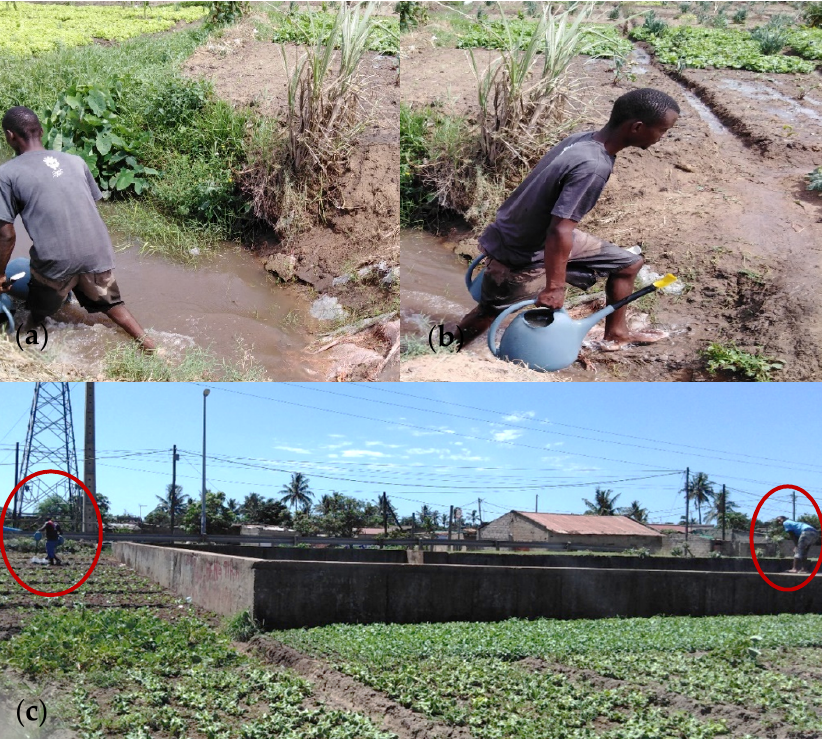
Figure 3. Farmers collecting water: ( a ) a man collecting water from artisanal well; ( b ) carrying it for irrigation in Infulene area; ( c ) manual crops irrigation (men at left) and water collection for irrigation, in a section of drainage ditch in the city of Maputo.